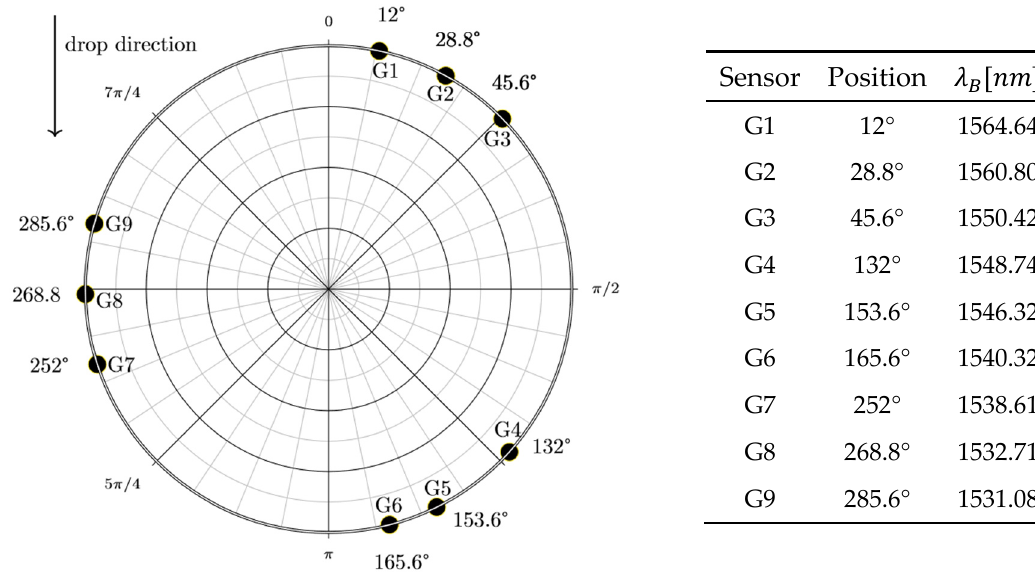
Figure 2. Damage made on the cylindrical specimen at 180° starting from the cylinder attachment point.